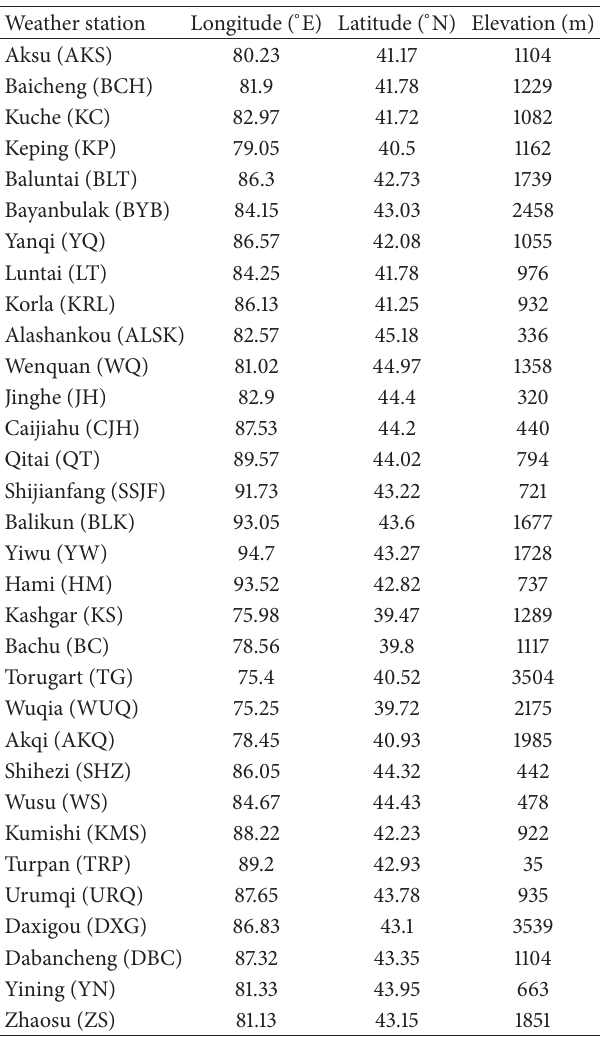
Table 1: Geographical coordinates of the meteorological stations of Tianshan mountainous